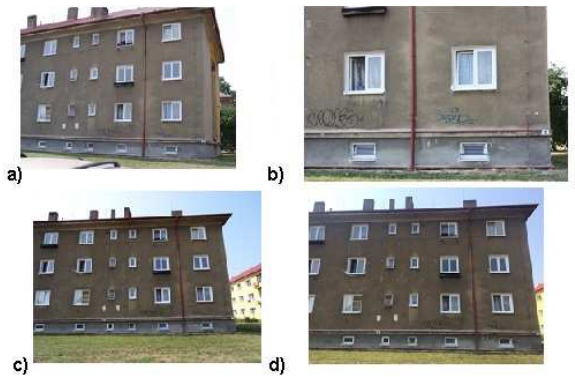
Figure 3. Image from camera: a) Pentax 645D; b) Canon EOS